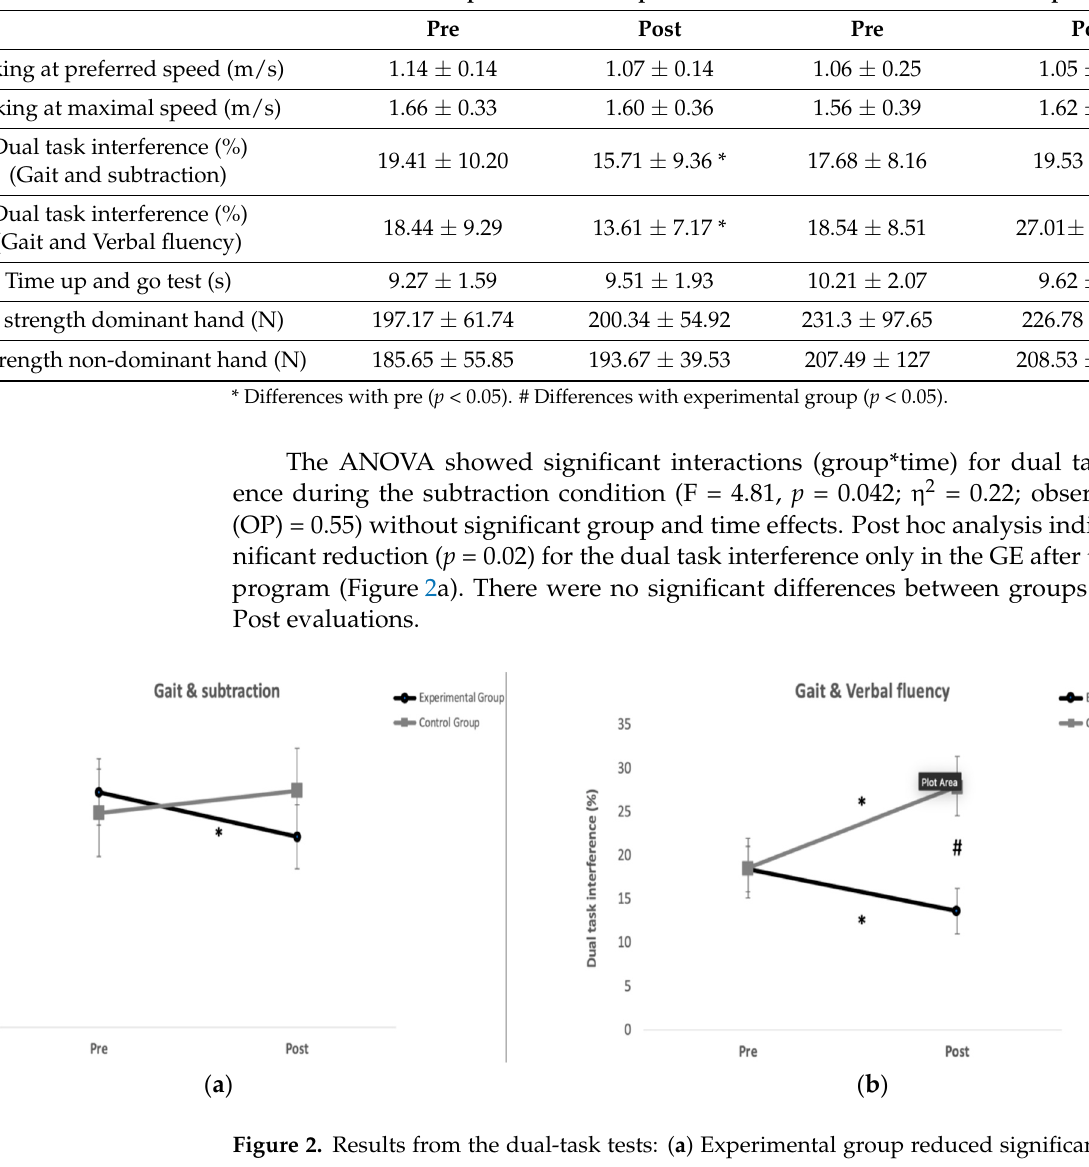
Table 3. Means and standard deviations in the performance of the tests before (Pre) and after (Post). Task Experimental Group Control Group Pre Post Pre Post Walking at preferred speed (m/s) 1.14 ± 0.14